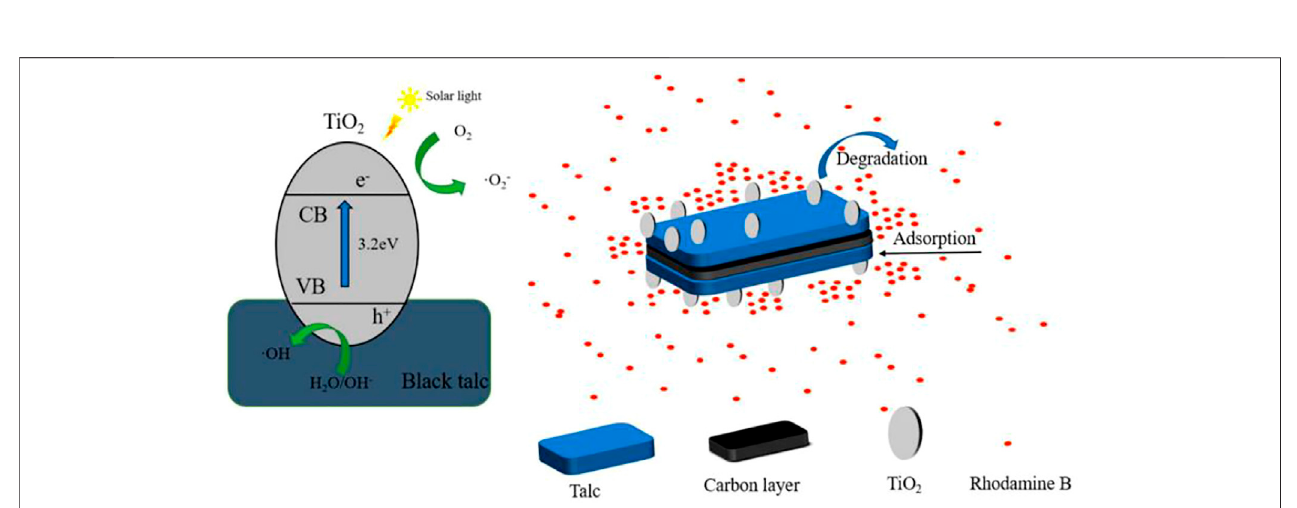
FIGURE 7 | Schematic diagram of photocatalytic performance enhancement mechanism of TiO 2 /Black Talc composite material (Shuai et al., 2021).